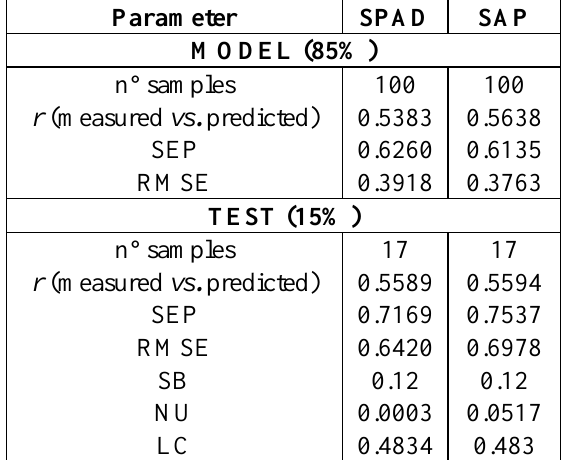
concentration in petiole) 3